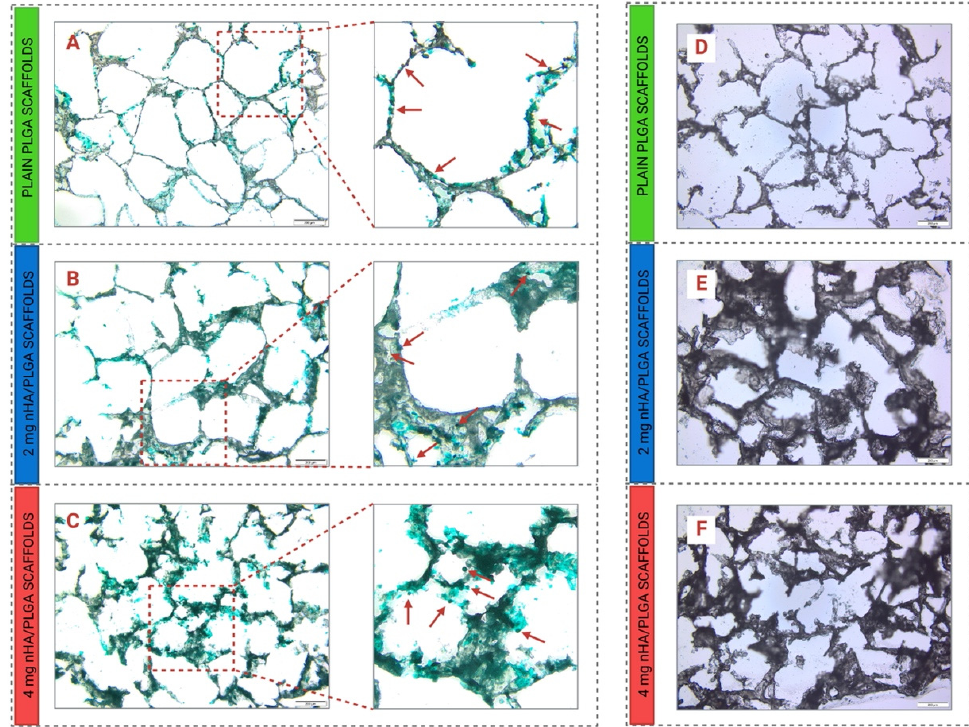
Figure 10. ( A – C ) Histological analysis of collagen type I deposition in co-culture at day 7 and ( D – F ) alkaline phosphatase (ALP) production by hFOB 1.19 cells in the different scaffolds. The deposition of collagen type I in the different scaffolds was assessed via staining with 0.5% Fast Green FCF on: ( A ) PLGA, ( B ) 2 mg nHA/PLGA scaffolds, and ( C ) 4 mg nHA/PLGA scaffolds. Red arrows indicate cells around the pores of the scaffolds. The production of ALP by hFOB 1.19 in co-culture was assessed via staining with Fast Blue BB/Naphthol AS-MX Phosphate on ( D ) PLGA, ( E ) 2 mg nHA/PLGA scaffolds, and ( F ) 4 mg nHA/PLGA scaffolds. Scale bar 200 μ m.